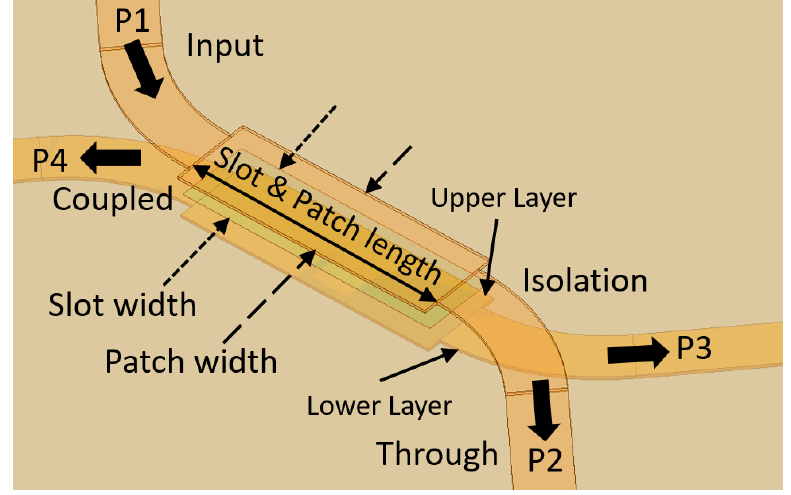
Figure 6. Layout of the dual-layer directional